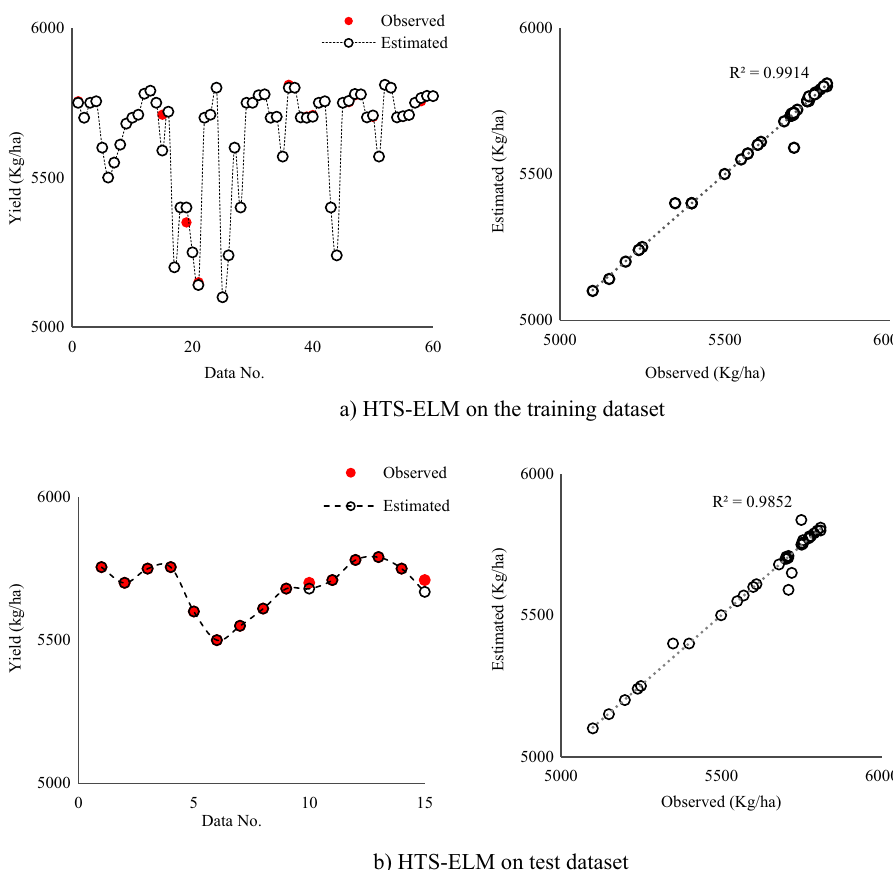
Fig. 7 a , b Comparison of esti- mated and observed